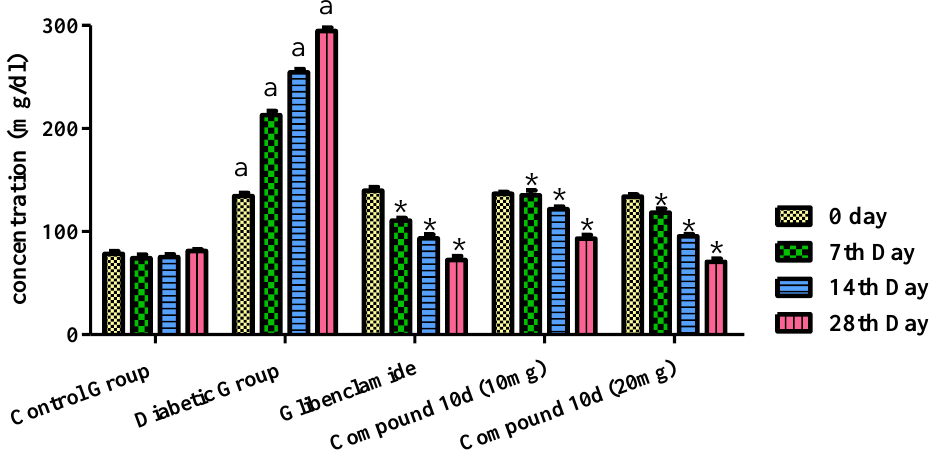
Figure 5. Effect of tested compound 10d on fasting plasma glucose level. Values were presented as mean ± SEM (number of animals, n = 6) and were different significantly a p < 0.05 in comparison to normal control group, * p < 0.05 when compared with diabetic control group.